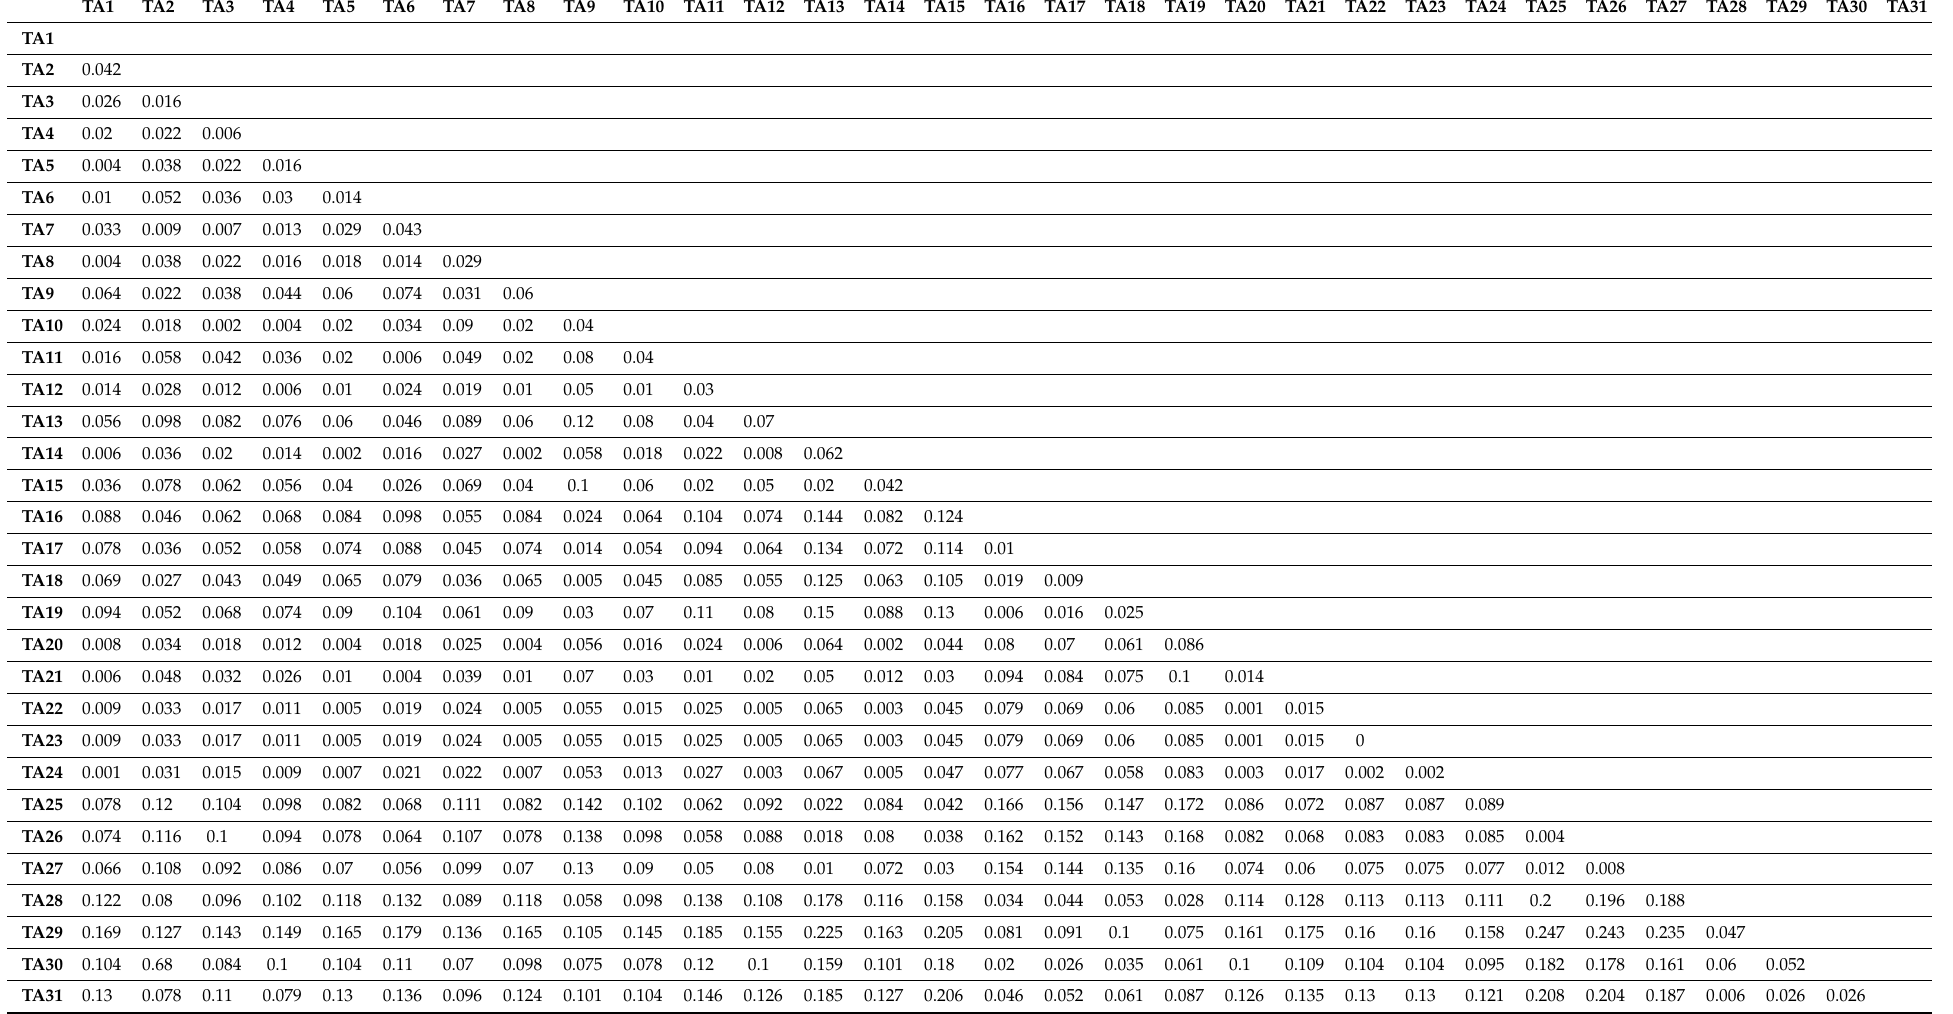
Table 5. Dissimilarity Matrix among wheat samples using the NJ method and dissimilarity